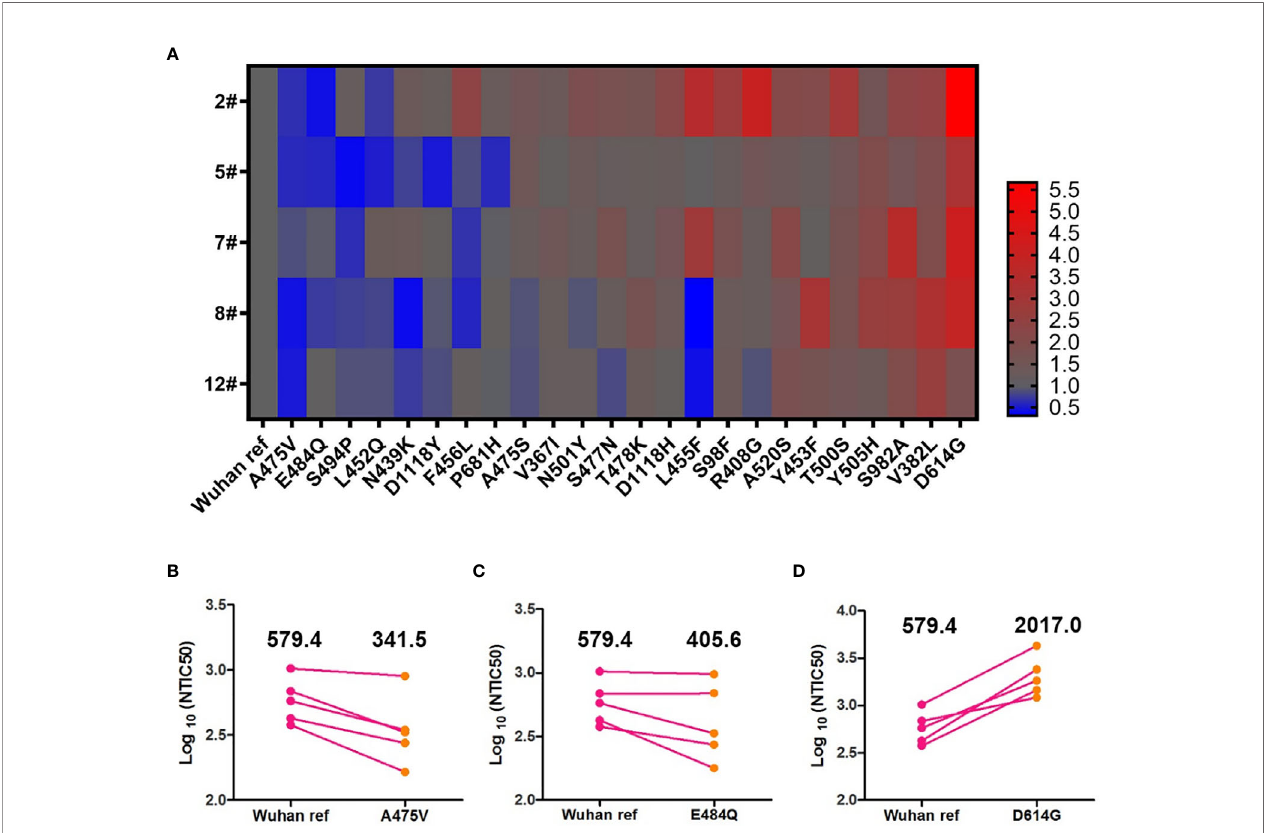
FIGURE 5 | Neutralization analysis of convalescent plasmas (n = 5) against the Wuhan reference and variant pseudoviruses. (A) Heat map of the relative neutralizing activities of the fi ve convalescent plasma samples against pseudoviruses bearing the variant spike proteins compared to the Wuhan reference pseudovirus. (Blue denotes reduction; red denotes increase). Paired neutralization analyses of fi ve convalescent plasma samples against the Wuhan reference and variant pseudoviruses of A475V, E484Q, and D614G are shown in (B – D) , respectively. GMT is shown above each graph. The difference of GMT was tested for statistical signi fi cance with a Wilcoxon matched-pairs signed rank test in the GraphPad Prism